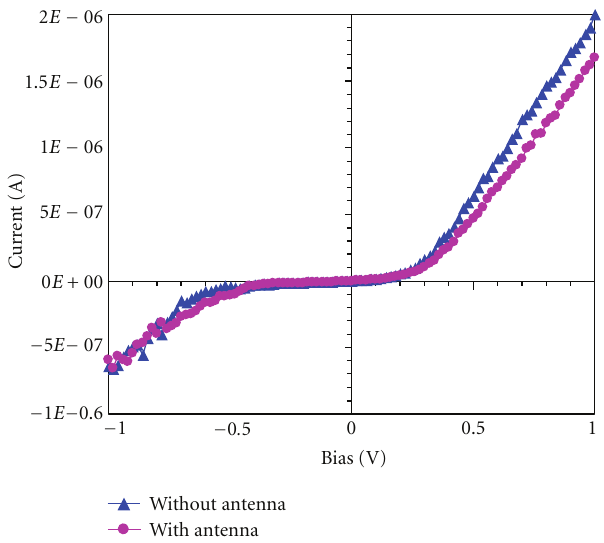
Figure 7: I-V characteristics of the CNT photodetector without and with the bowtie